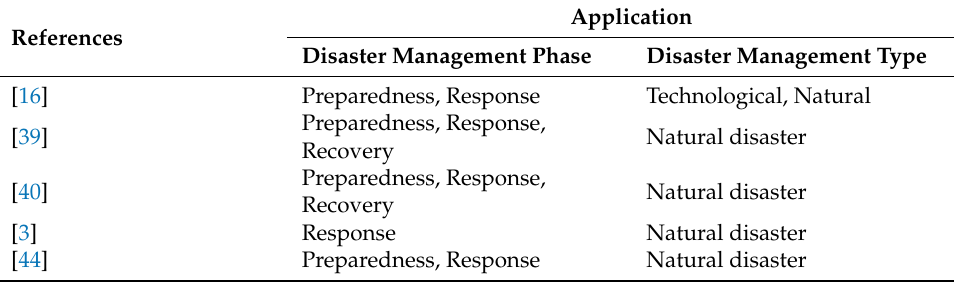
Table 7. Applications of social media data in disaster